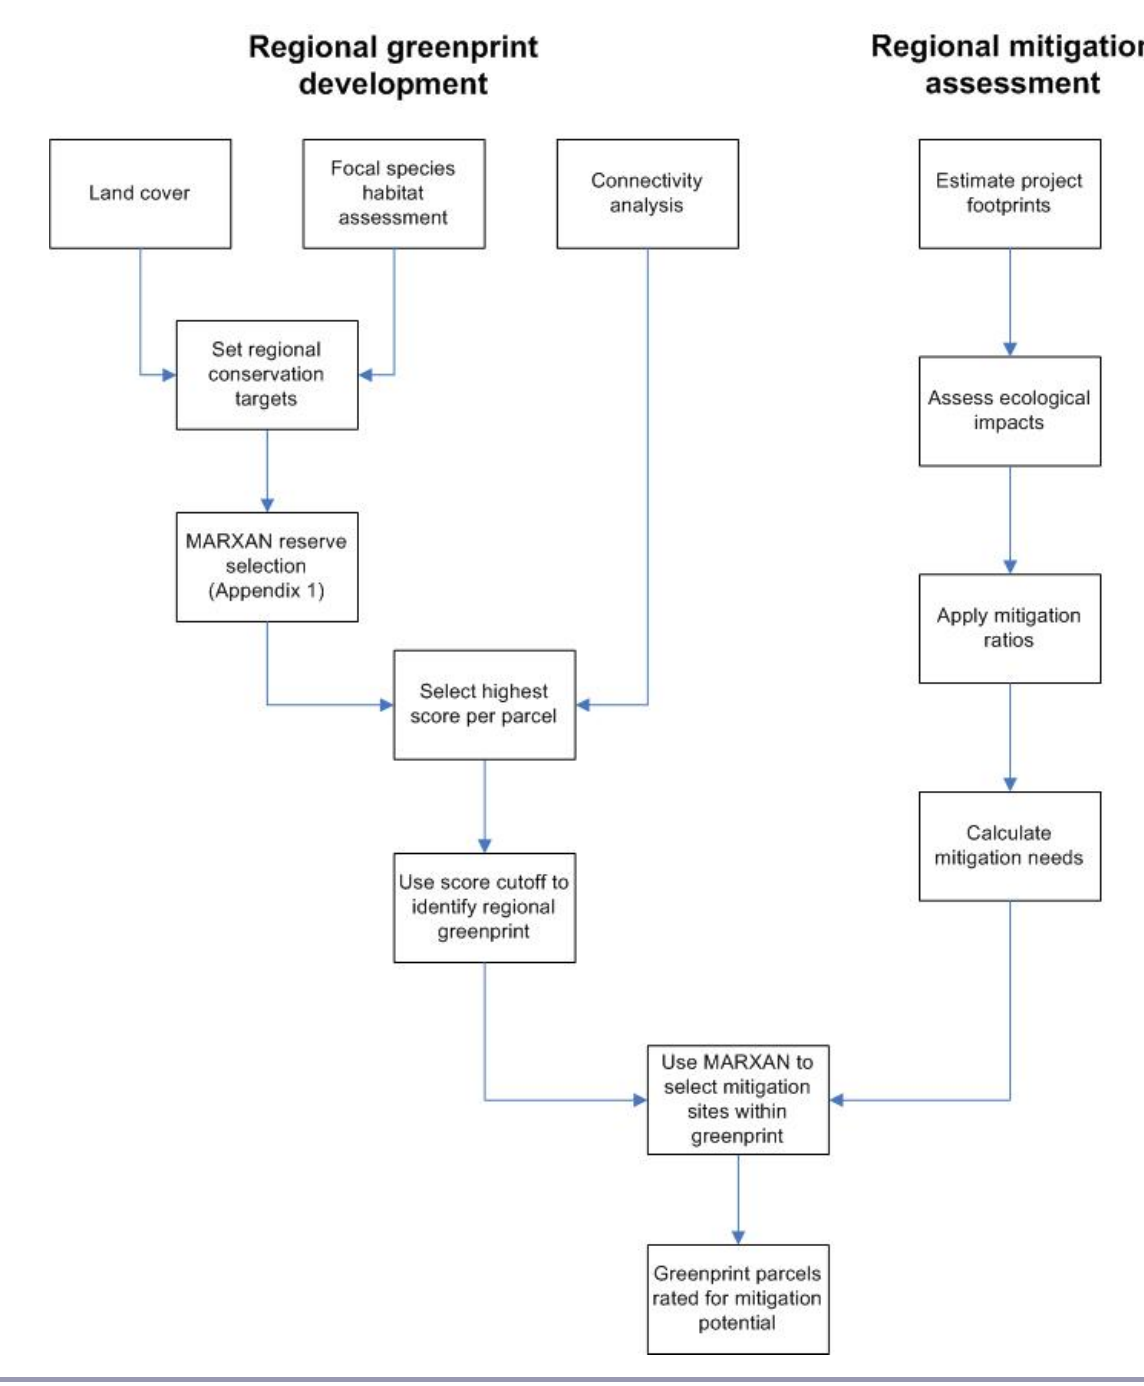
Fig. 1. Steps taken to develop a regional greenprint of conservation needs (left-side process) and integrate a transportation agency’s compensatory mitigation obligations into the greenprint (right-side